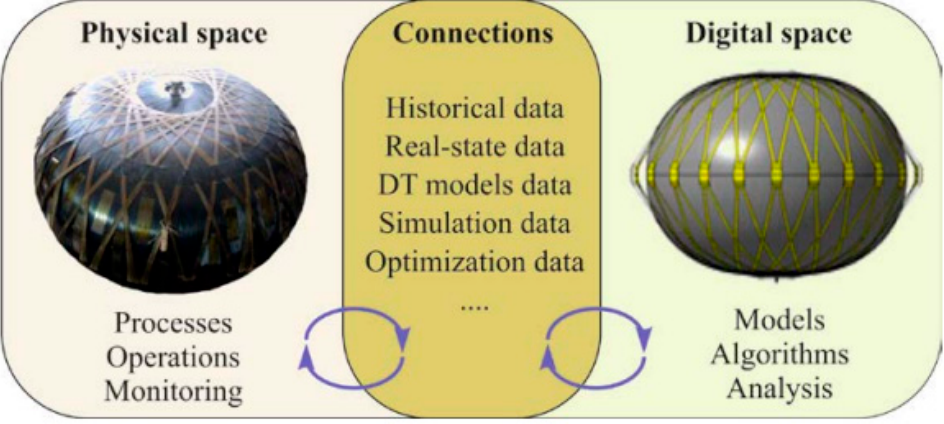
Figure 35. Concept of digital twin for composite pressure vessels [134].